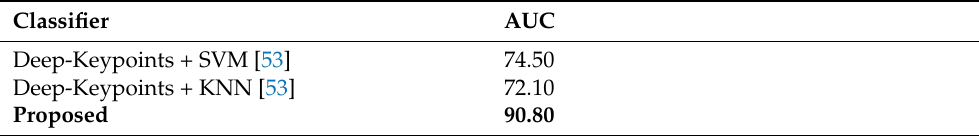
Table 6. Comparative assessment of the presented model with ML-based algorithms.